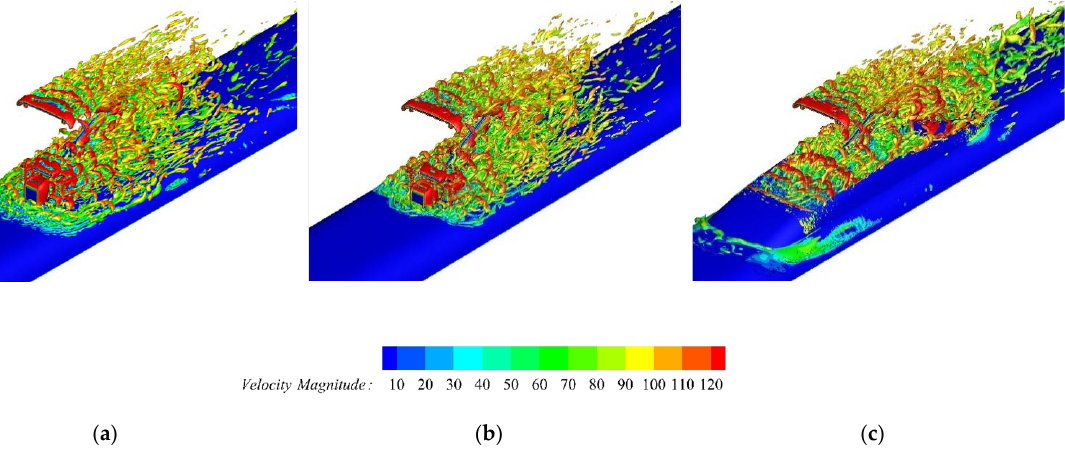
Figure 9. Iso-surface of the instantaneous normalized Q-criterion. ( a ) Case 1; ( b ) case 2; ( c ) case 3.